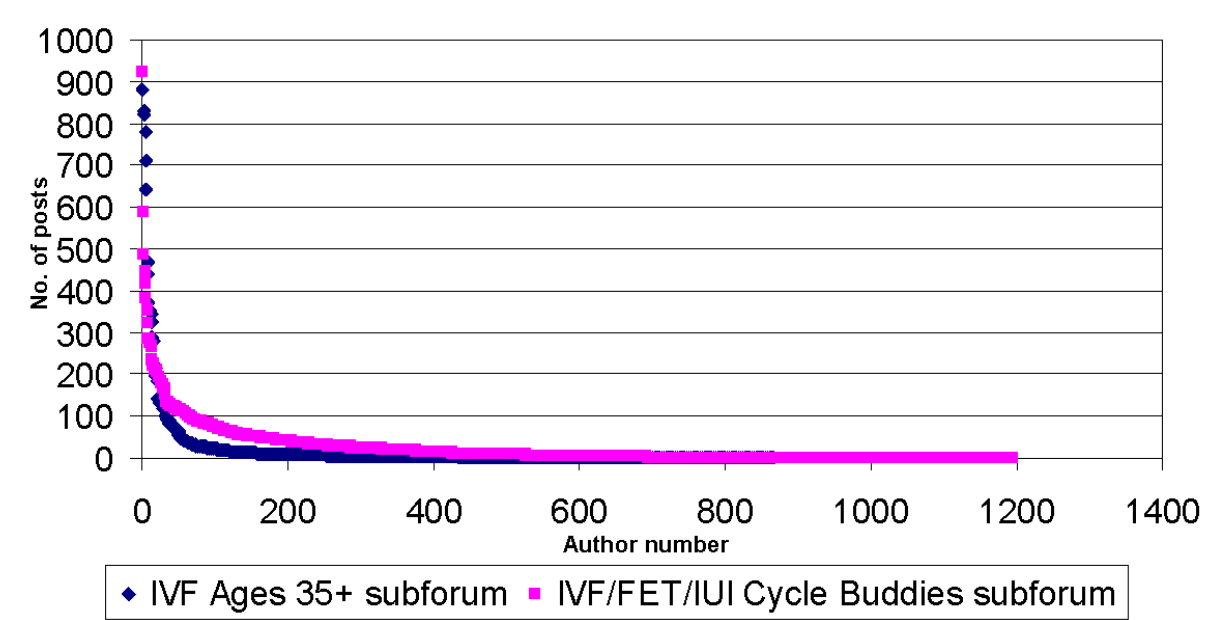
Figure 2. Distribution of the number of posts per author (most prolific) for IVF Ages 35+ subforum